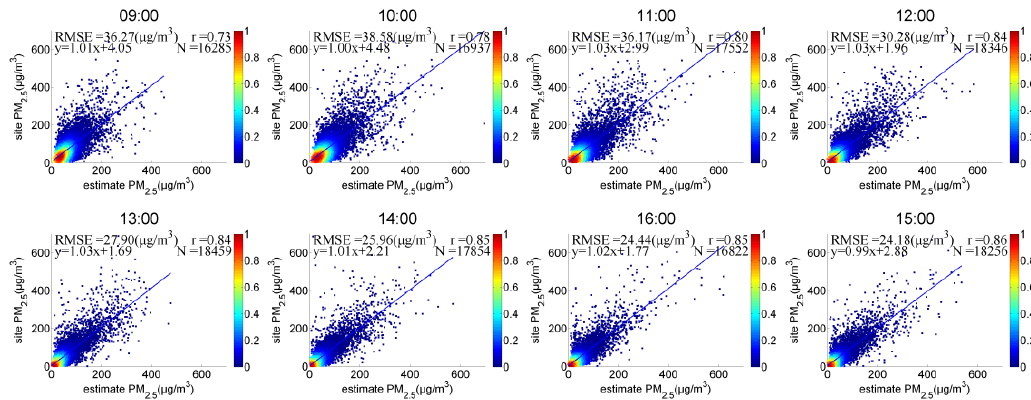
Figure 9. Hourly PM 2.5 of satellite-retrieved and ground-measured PM 2.5 data in Hebei.